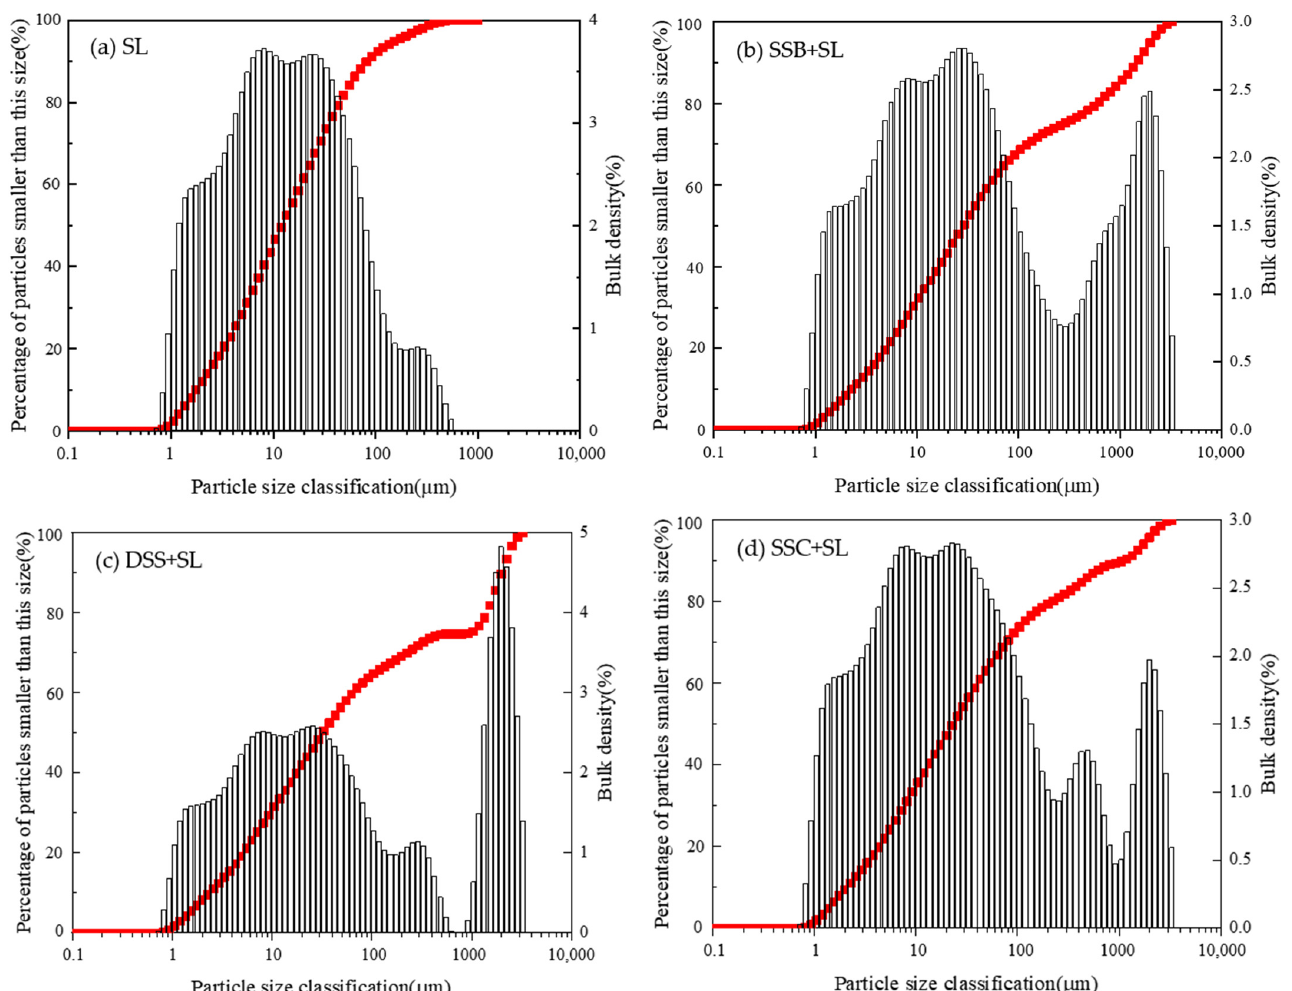
Figure 3. The particle gradation curve of four different samples. Table 4. Particle size distribution and texture grades of four different sample